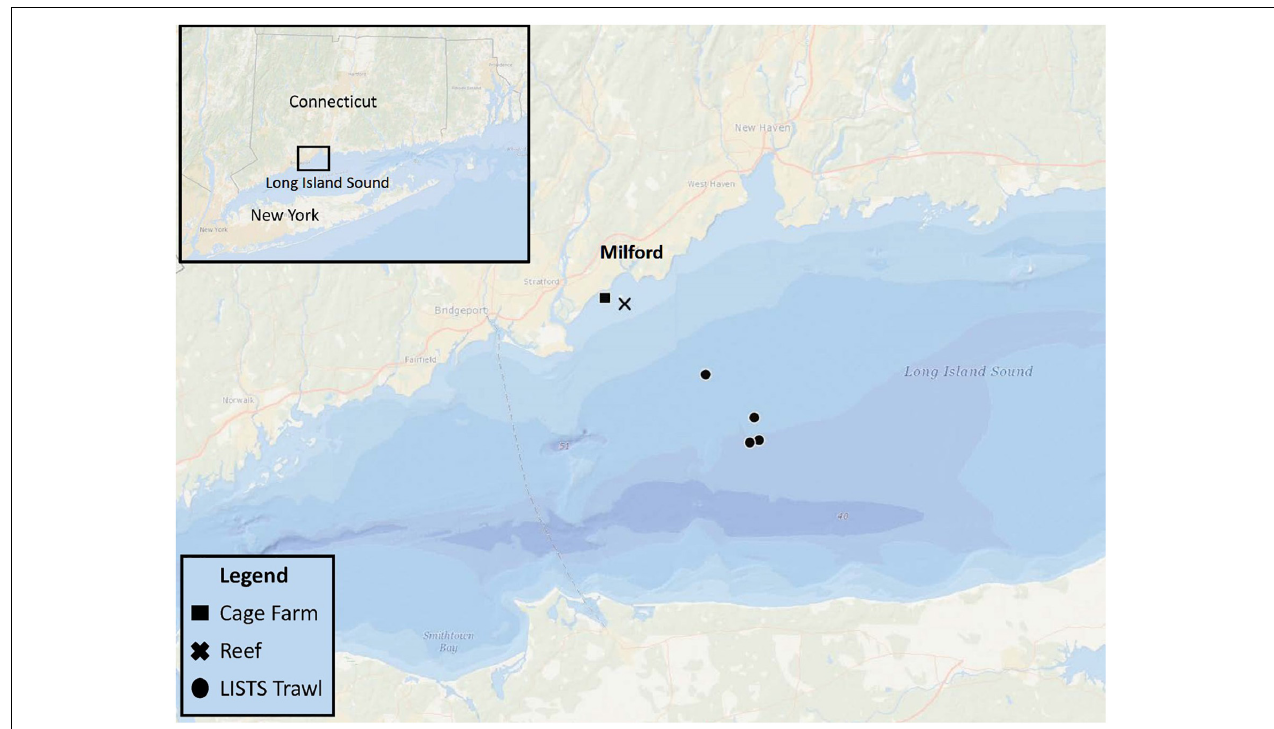
FIGURE 1 | eDNA sampling sites: an oyster aquaculture cage farm (Cage Farm, 41 ◦ 11.379 (cid:48) N, 73 ◦ 04.170 (cid:48) W) and nearby cobble and boulder reef (Reef, 41 ◦ 1.175 (cid:48) N, 73 ◦ 3.762 (cid:48) W). Three CT DEEP trawling sites (LISTS Trawl) northeast to the eDNA sampling